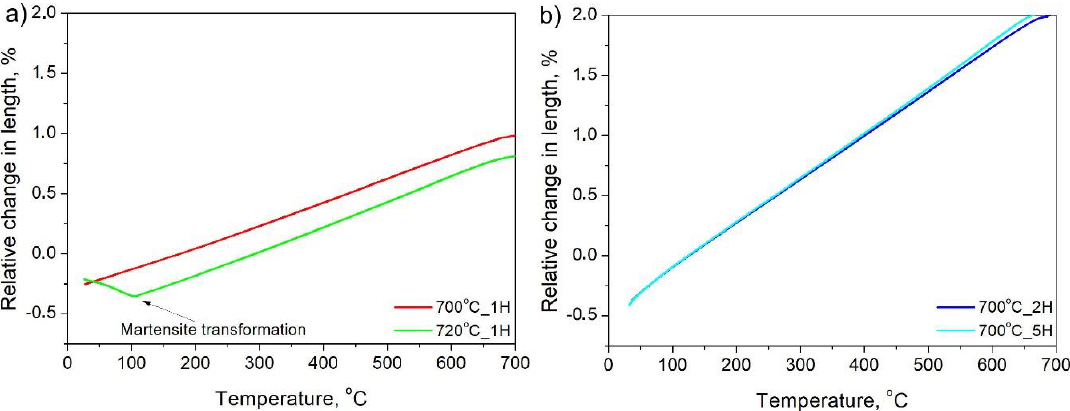
Figure 7. Dilatometric results during cooling to room temperature after intercritical annealing: ( a ) annealing at 700 and 720 °C for 1 h; ( b ) annealing at 700 °C for 2 and 5 h.